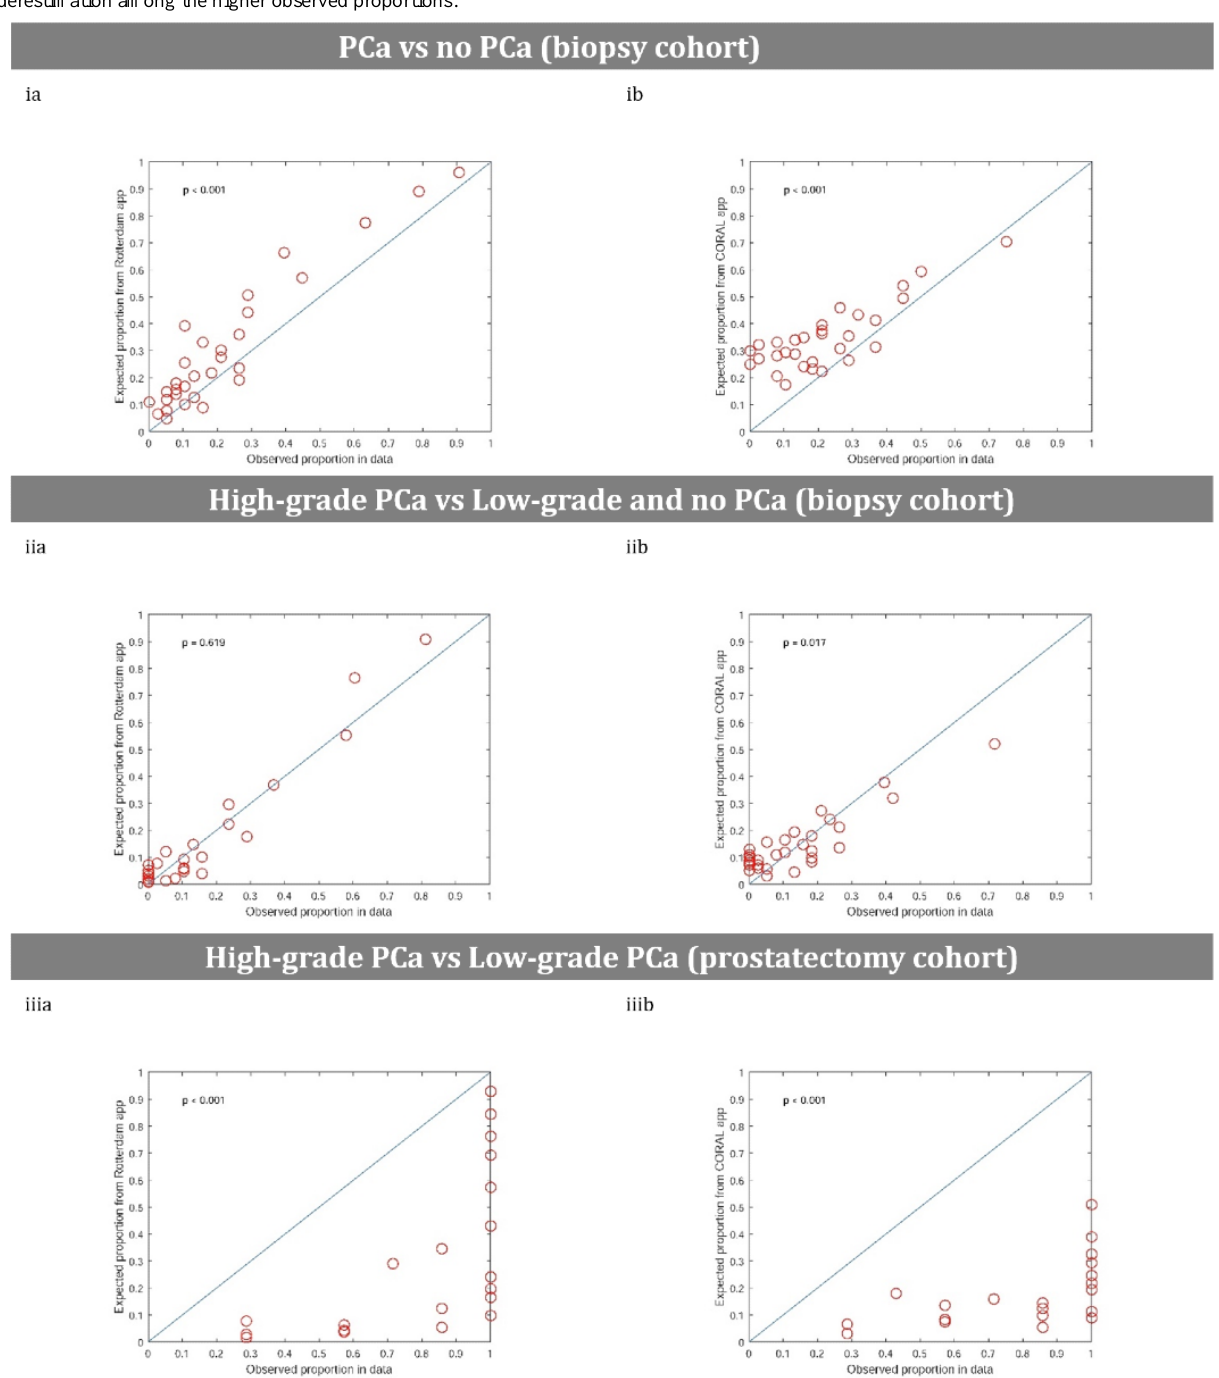
Figure 2. Calibration plots comparing (a) the Rotterdam app and (b) Coral app showing the agreement between (i) predicted and observed probabilities for diagnosing prostate cancer (PCa) and (ii) high-grade PCa in the biopsy cohort, and (iii) high-grade PCa in the prostatectomy cohort. Each circle in the plots represents a group of patients with an observed probability of PCa or high-grade PCa on the x-axis, corresponding to an average calculated risk of PCa or high-grade PCa by the apps on the y-axis. Figures (ia) and (ib) demonstrated overestimation, whereas Figures (iiia) and (iiib) illustrated underestimation. Only Figure (iia) showed a good calibration; in Figure (iib), overestimation was revealed among the lower observed proportions and underestimation among the higher observed